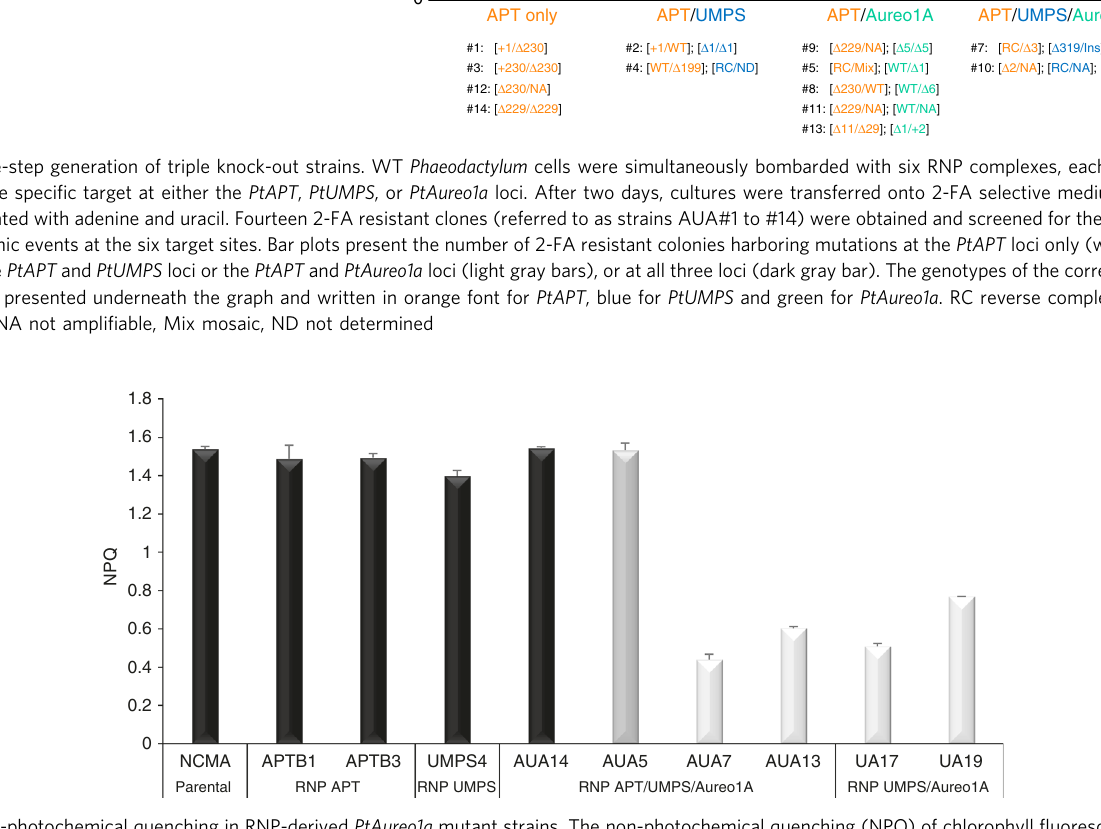
Fig. 6 Non-photochemical quenching in RNP-derived PtAureo1a mutant strains. The non-photochemical quenching (NPQ) of chlorophyll fl uorescence was measured after ten minutes of illumination with 700 µ mol photons m − 2 s − 1 of actinic red light. The parental NCMA strain, two PtAPT single mutants (APTB1 and APTB3), a PtUMPS single mutant (UMPS4) and strain AUA14 showing no TM at the PtAureo1a loci served as controls (black bars). Several strains derived from multiplexing experiments — including a PtAureo1a monoallelic mutant (AUA5; dark gray bar), as well as PtAureo1a biallelic mutants (AUA7, AUA13, UA17, and UA19; light gray bars) — were characterized. The genotypes of these strains are shown in Supplementary Fig. 14. Data are the average of n = 2 independent repeats, bars show SD